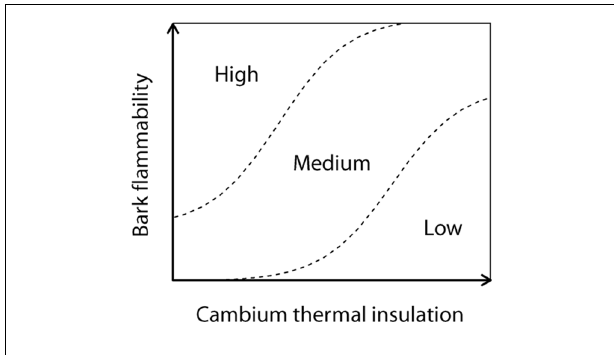
FIGURE 1 |Tree susceptibility to fire-induced top-kill (conceptual model); the cambium insulating ability of tree (as a surrogate of the insulating ability of vital conducting tissues) and the propensity of the bark to burn and char, i.e., the bark flammability, express both the tree susceptibility to endure lethal fire